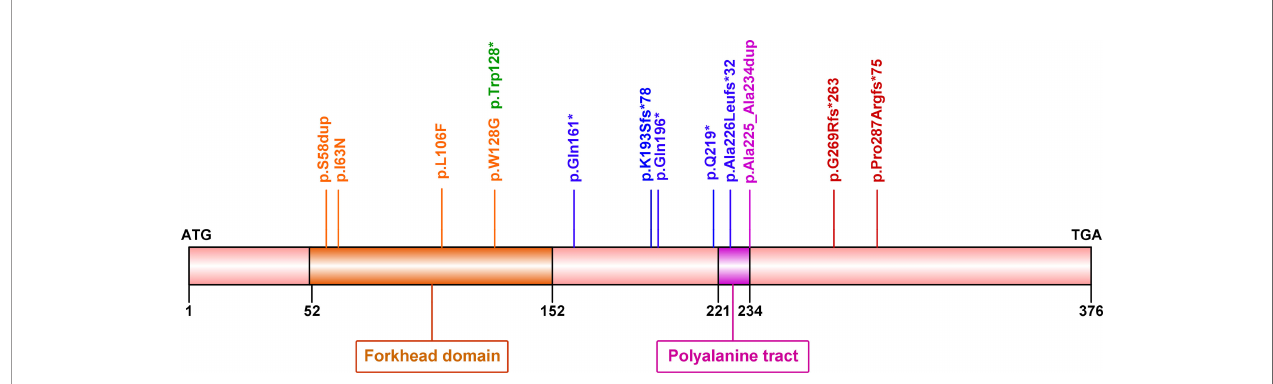
FIGURE 1 | Diagram showing forkhead box L2 ( FOXL2 ) protein structure and mutations identi fi ed in the current study. Human FOXL2 encodes a 376 amino acid protein, containing a DNA-binding forkhead domain (amino acid 52 – 152) and a polyalanine tract (amino acid 221 – 234).